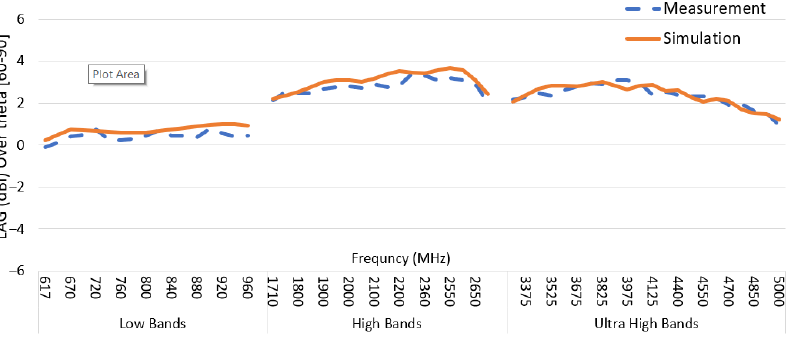
Figure 17. AUT linear average gain for elevation zone theta (60 – 90 ○ ) across the frequency range for prototype measurement and simulation data.